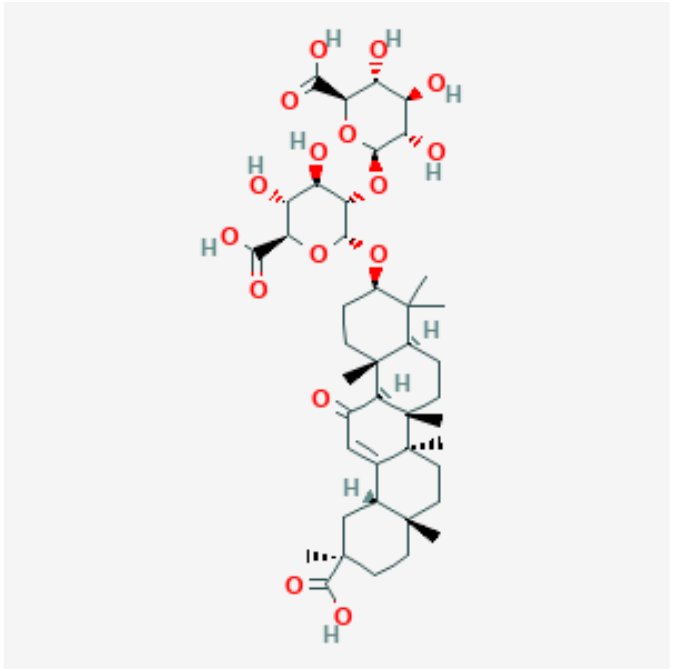
Figure 1. The structural of GA (PubChem CID 14982, accessed on 14 May 2022).